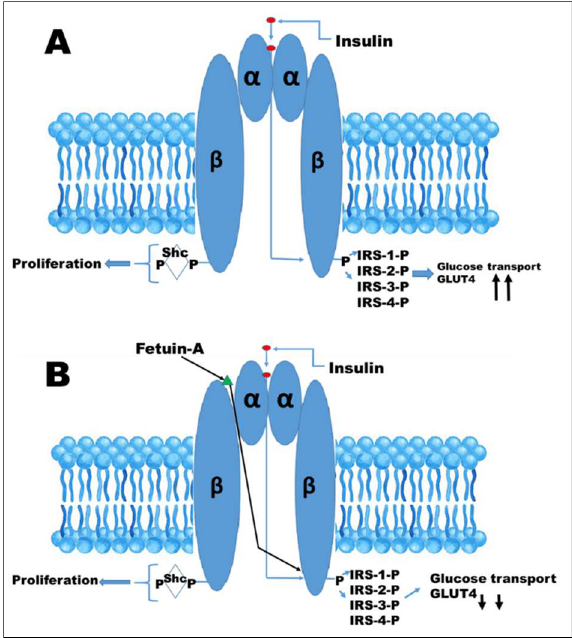
Figure 3. Insulin signaling. ( A ), activation of the insulin receptor by binding of insulin to the α -subunits of its receptor, initiates autophosphorylation of the intracellular portion of the β -subunits, resulting in the recruitment and phosphorylation or receptor substrates such as IRS-1, IRS-2, IRS-3, and IRS-4 Shc proteins. Shc activates Ras-MAP pathway, culminating in proliferation. IRS proteins activate the PI3K-AKT pathway, the signal of which is transmitted to promote translocation of GLUT4 and glucose transport into the cell. ( B ), the binding of fetuin-A to the extracellular portion of beta subunit attenuates tyrosine kinase signaling, resulting in reduced glucose transport and hence a possible source for insulin resistance.